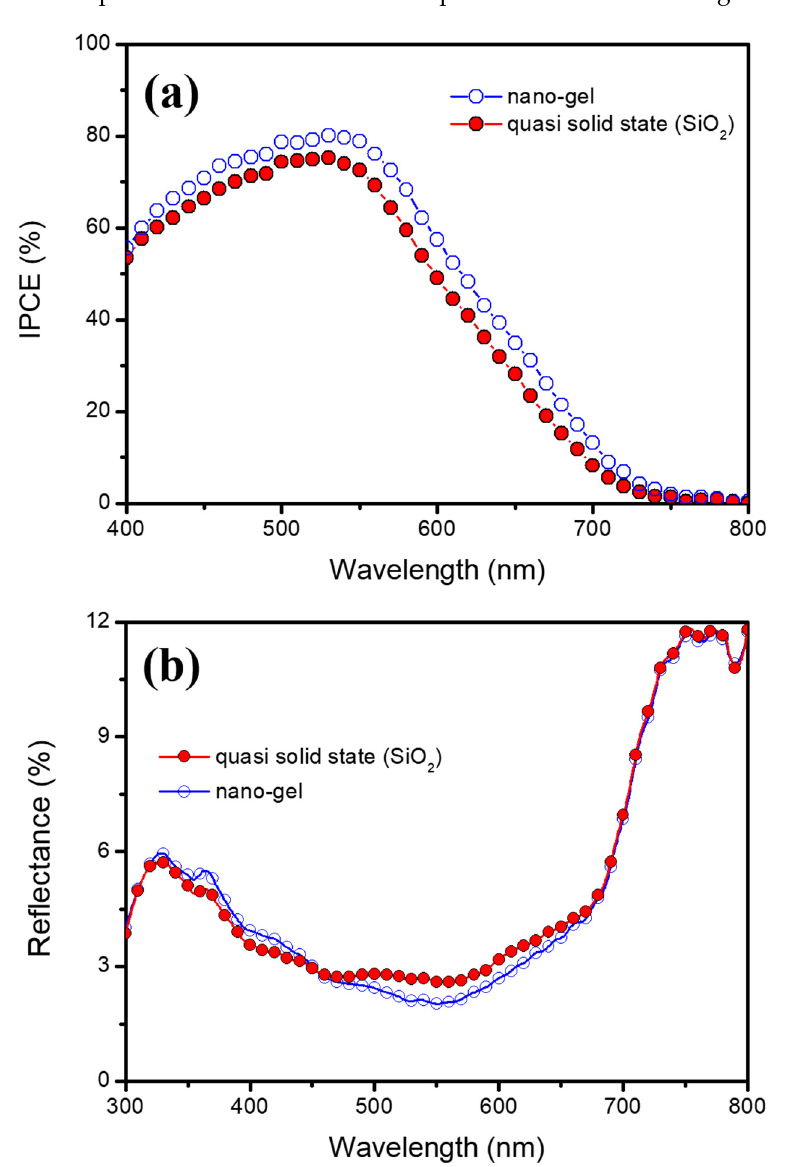
Figure 4. ( a ) IPCE and ( b ) diffuse reflectance spectra of DSSCs based on nanogel and quasi-solid-state (SiO 2 ) electrolytes.